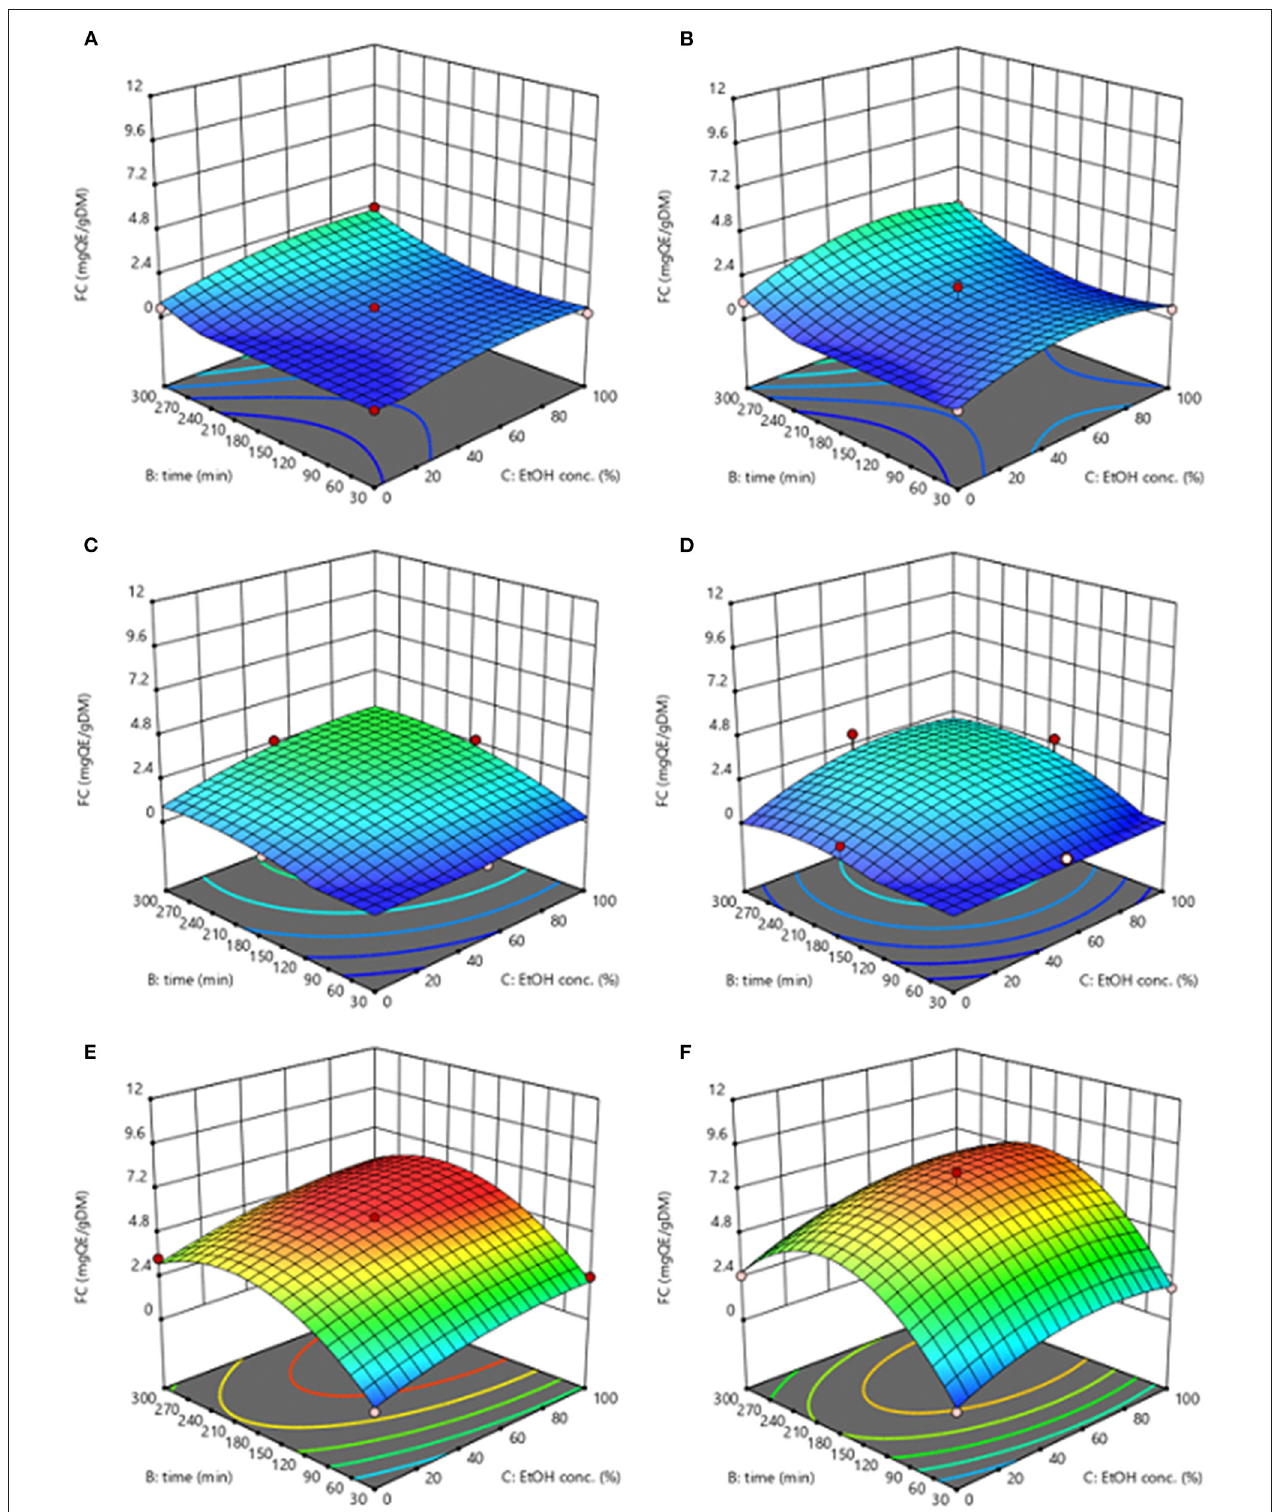
FIGURE 3 | Response surfaces for total flavonoids of extracts obtained from untreated (Control) (A,C,E) and PEF-treated (E = 3.8 kV/cm; W T = 10kJ/kg) (B,D,F) grape pomace as a function of extraction time and ethanol concentration, with the extraction temperature set at 20 ◦ C (A,B) , 35 ◦ C (C,D) , 50 ◦ C (E,F) .